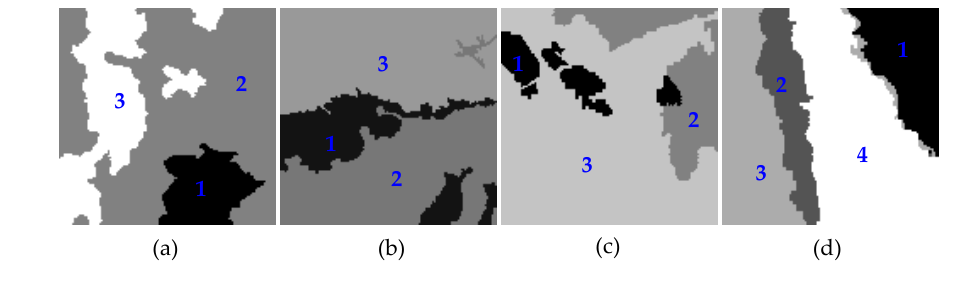
Figure 8. Results of real SAR images: ( a1 )–( d1 ) Texture features, ( a2 )–( d2 ) boundary features, ( a3 )–